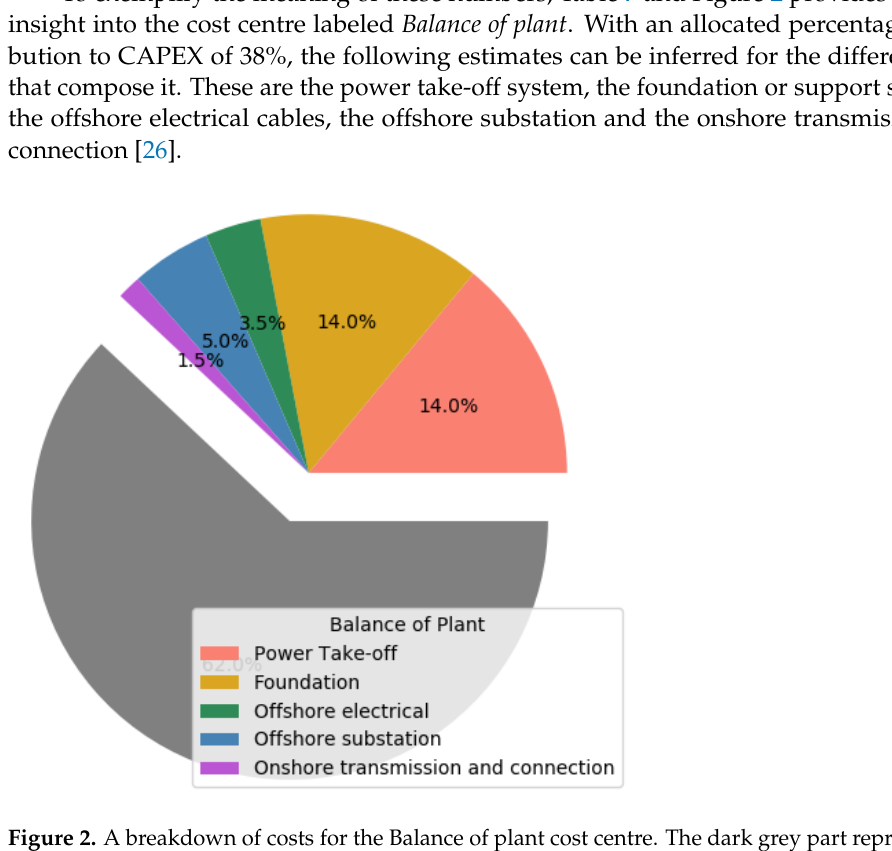
Figure 2. A breakdown of costs for the Balance of plant cost centre. The dark grey part represents the rest of the